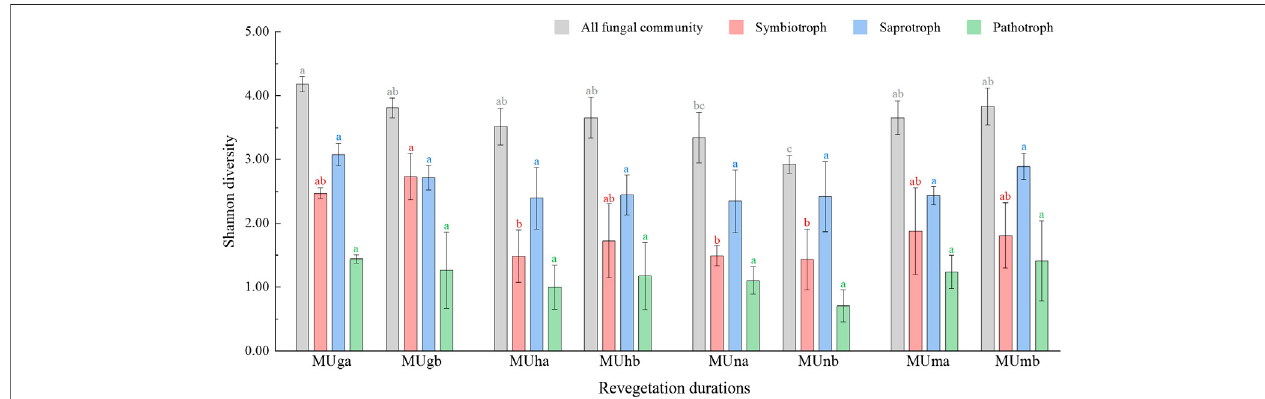
FIGURE 2 | Shannon index of all fungi community and functional groups in different soil depths trough revegetation durations. Different letters are signi fi cantly different ( p <